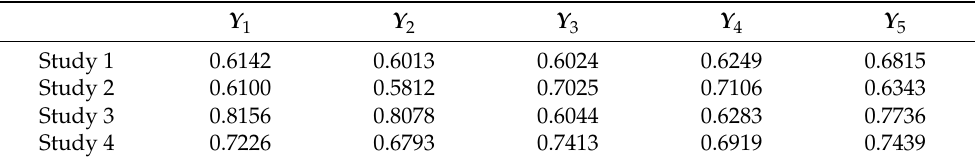
Table 6. Grey relational